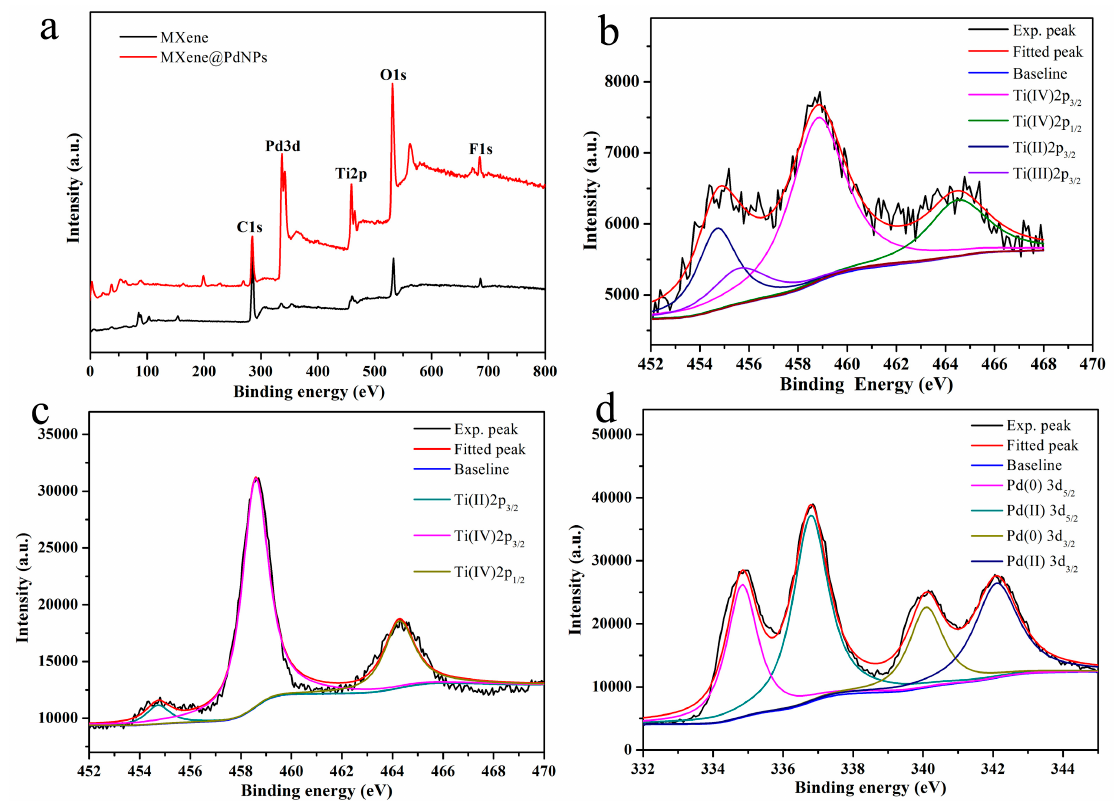
Figure 5. ( a ) XPS profiles of the MXene and MXene@PdNPs samples; ( b ) Ti2p in MXene; ( c ) Ti2p in